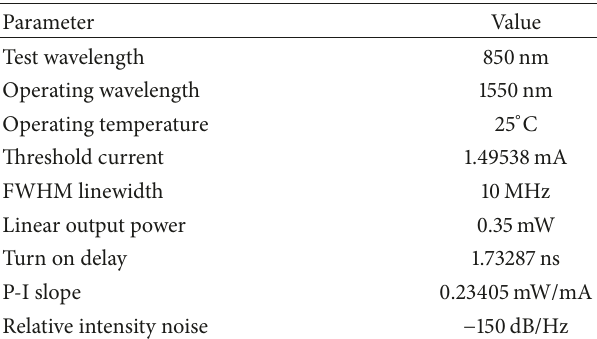
Table 1: VCSEL laser emitter parameters. Table 2: Different parameters for